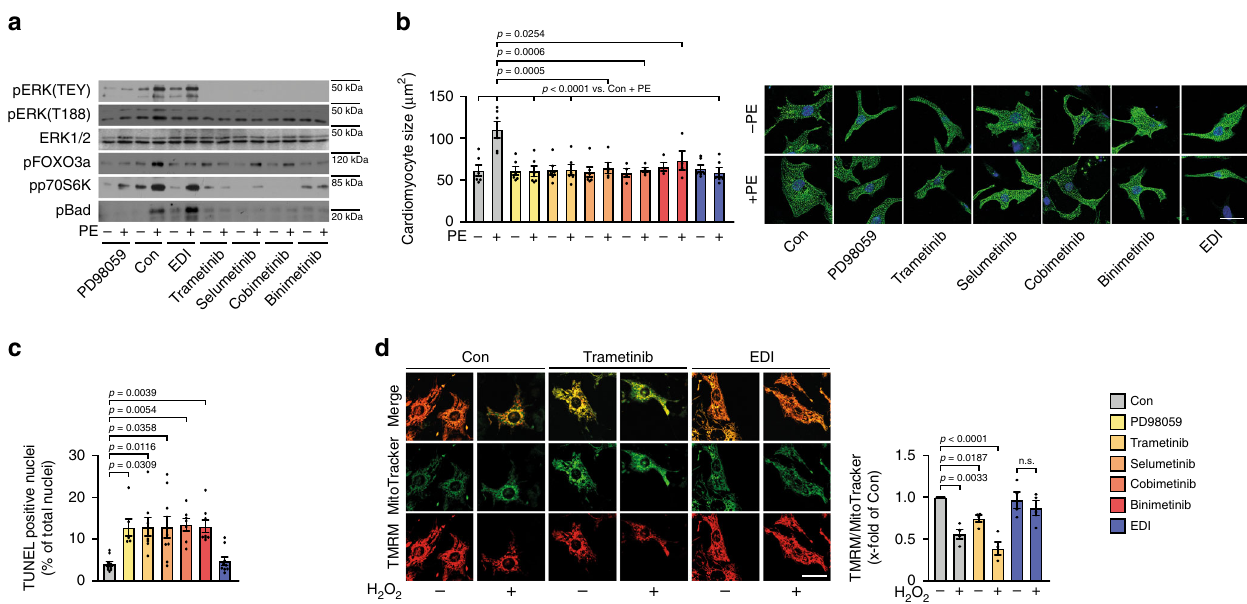
Fig. 6 EDI protects from cardiomyocyte toxicity. a – d NRCM transduced with LacZ (Con) or EDI and pretreated with PD98059 (30 µ M), trametinib (15 µ M), selumetinib (1 µ M), cobimetinib (5 µ M), and binimetinib (10 µ M) for 1 h. a Representative western blots of pERK(TEY), pERK(T188), pFOXO3a (S294), pp70S6K(T421/S424), and pBad(Ser112); PE stimulation (4 µ M, 10 min). Quanti fi cations: Supplementary Fig. 9A. b Cardiomyocyte size in response to PE (4 µ M, 24 h); phalloidin-stainings (scale bar 25 µ m) and quanti fi cations (cobimetinib-PE, cobimetinib + PE, binimetinib-PE, and binimetinib + PE n = 4; selumetinib + PE n = 5; for all other conditions n = 6; 50 – 70 cells per group and experiment). c TUNEL-assay (Con, selumetinib, EDI, n = 9; PD98059, n = 6; trametinib, binimetinib, n = 8; cobimetinib, n = 7, >100 cells per experiment and group). d Assessment of mitochondrial membrane potential in response to H 2 O 2 (100 µ M, 15 min). Tetramethylrhodamine-methyl-ester- (TMRM, red) and MitoTrackerGreen-stainings (green) (scale bar